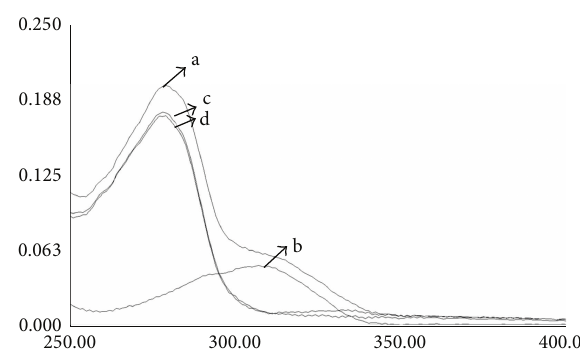
Figure 6: The UV absorption spectra of HSA-warfarin (a), warfarin (b), (HSA-warfarin)-warfarin (c), and HSA (d) 𝐶 ( 4 × 10 −6